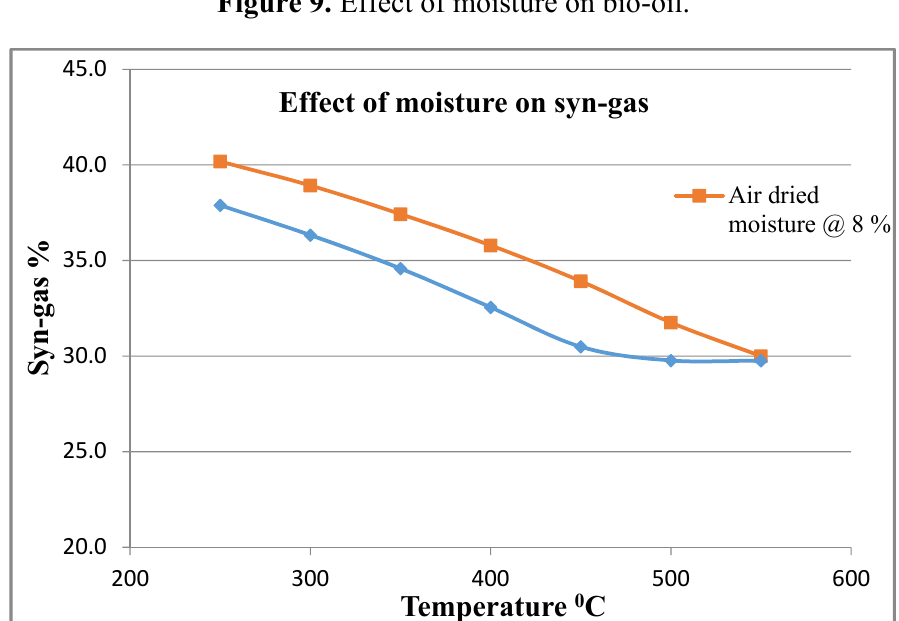
Figure 10. Effect of moisture on